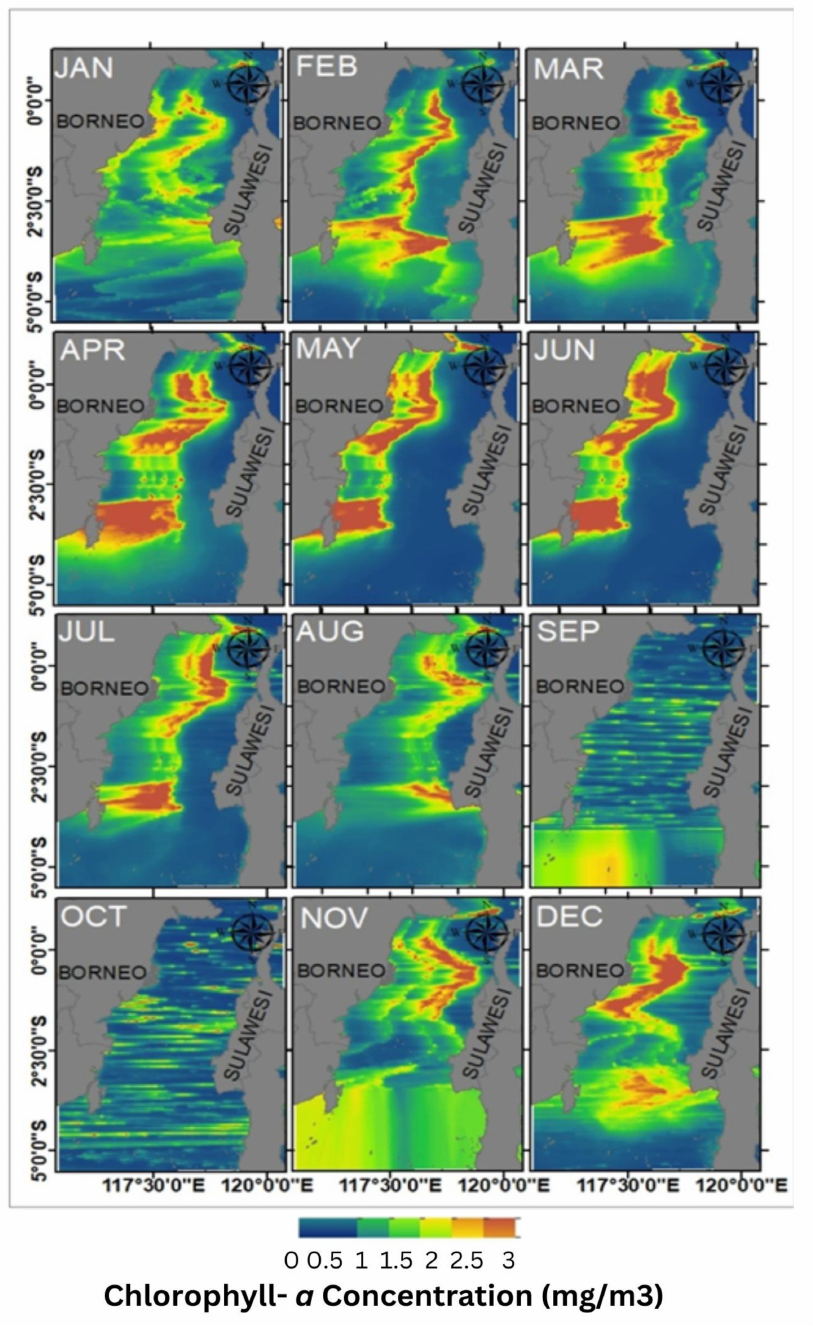
Figure 3. The Spatial Distribution Map of Average Chlorophyll- a 2015–2020 in the Makassar